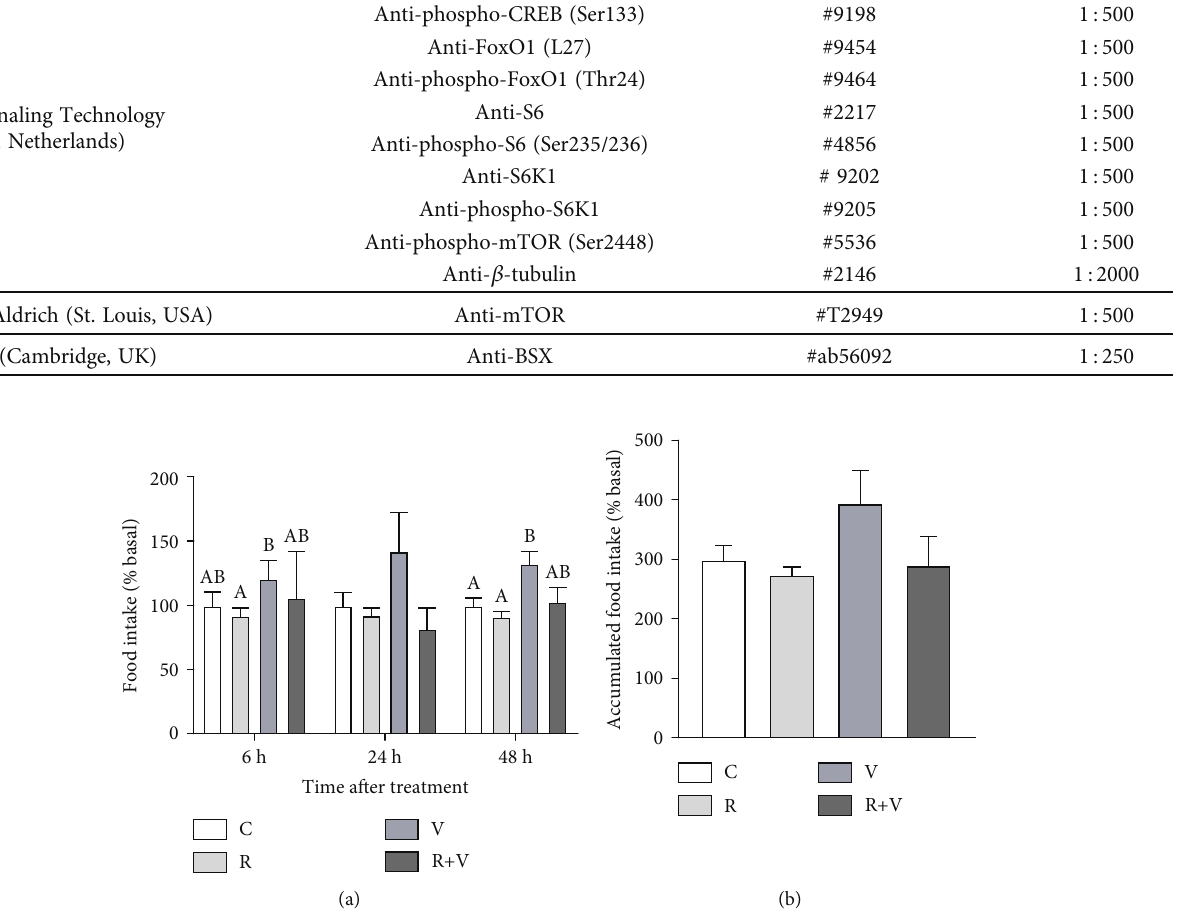
Figure 1: Feed intake was measured in rainbow trout after 6, 24, and 48h of intracerebroventricular injection of 1 μ L · 100 g -1 body mass of a solution containing saline and dimethyl sulfoxide (DMSO) alone (control) or containing 20mM rapamycin (R), 80mM of L-valine (V), or rapamycin with valine (R+V). (a) Feed intake is shown as a percentage of ingested feed compared with basal levels (average of intake 3 days prior to experiment) and normalized to the control group (100%). Values are mean + SEM of feed intake assessed in 3 di ff erent tanks (12 fi sh per tank) per treatment. Signi fi cant di ff erences ( P < 0 : 05 ) among groups are denoted with di ff erent letters. (b) Accumulated feed intake is shown as mean + SEM of the summatory of the percentage of feed ingested calculated each